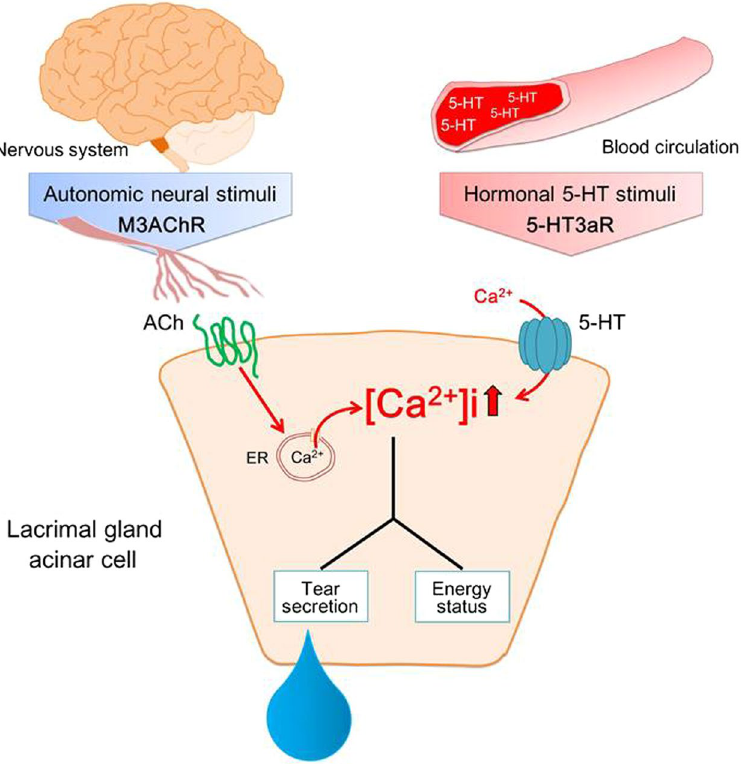
Figure 7. Outline of hormonal regulation of tear secretion by serotonin. 5-HT3aR, a ligand-gated ion channel that induces intracellular calcium ([Ca 2 + ]i) mobilization through entry of extracellular Ca 2 + into the cell, is located in the basolateral lacrimal gland (LG). [Ca 2 + ]i in the LG acinar cells, which are responsible for maintaining aqueous tear secretion and cellular energy, is regulated by the interaction between 5-HT3aR and m3AChR activity via blood 5-HT and neuronal parasympathetic stimulation, respectively. Tear secretion is maintained at an optimum level by the simultaneous action of blood 5-HT and the neural parasympathetic pathway. Abbreviations: ACh, acetylcholine; ER, endoplasmic reticulum; m3AChR, M3 muscarinic acetylcholine receptor; 5-HT, serotonin; 5-HT3aR, serotonin type 3a